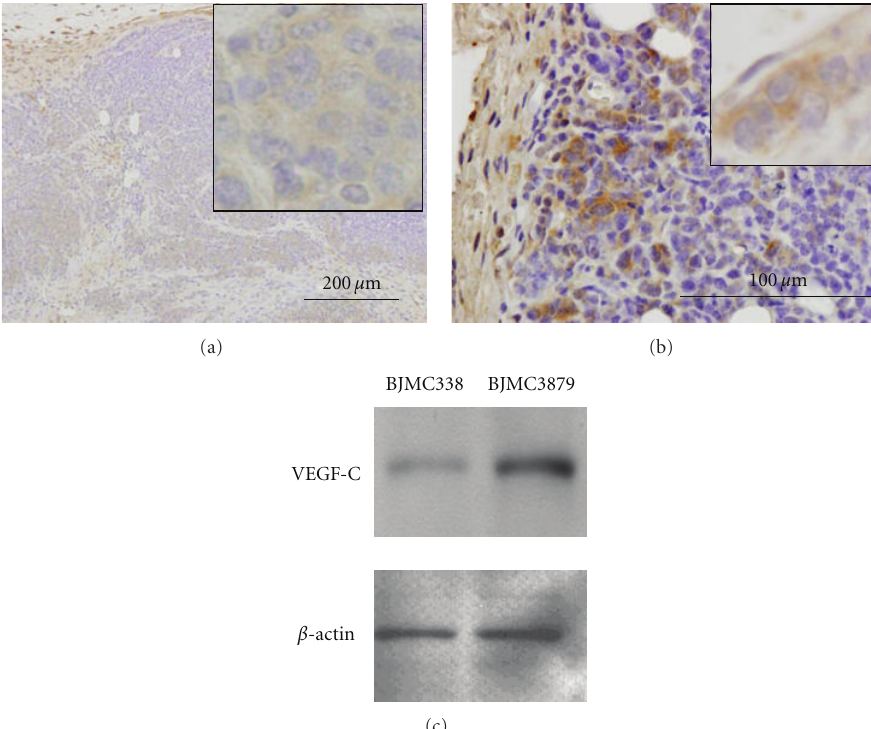
Figure 7: Immunohistochemistry (a and b) and Western blot analysis (c) of VEGF-C in BJMC338 tumor (a and c) and BJMC3879 tumor (b and c) at 8 weeks postinoculation.